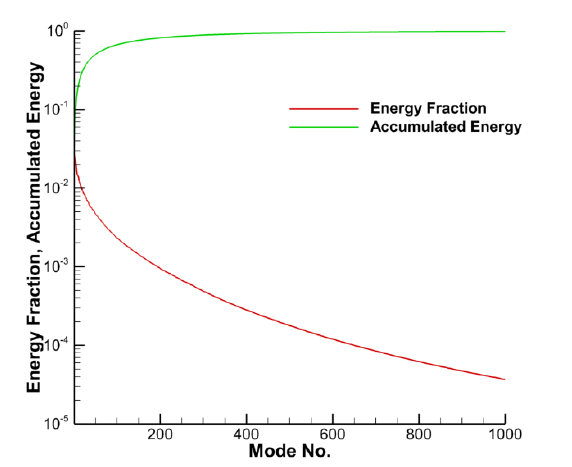
Fig. 9. Energy distribution across the velocity POD